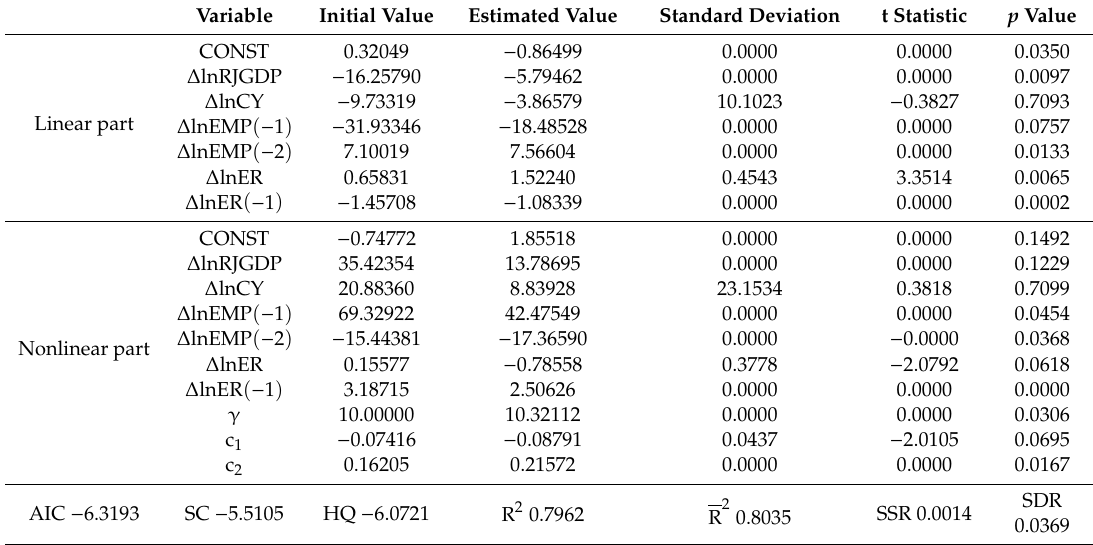
Table 5. LSTR2 model parameter estimation